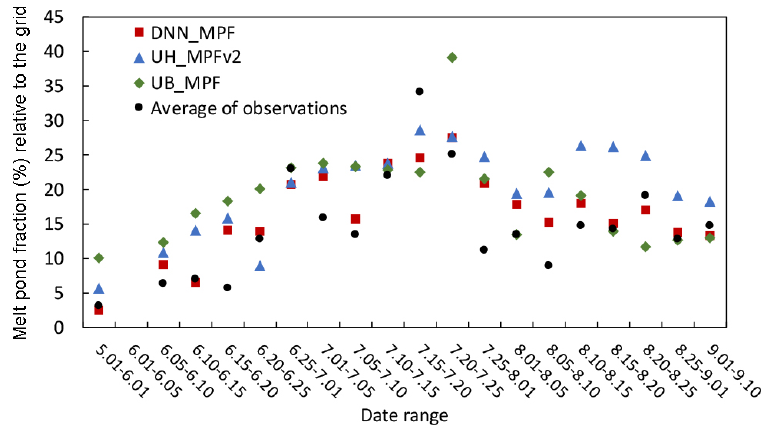
Figure 16. Comparison of the evolution of the three retrieved MPFs relative to the grid against the observations in the period of May to September during 2003–2011.